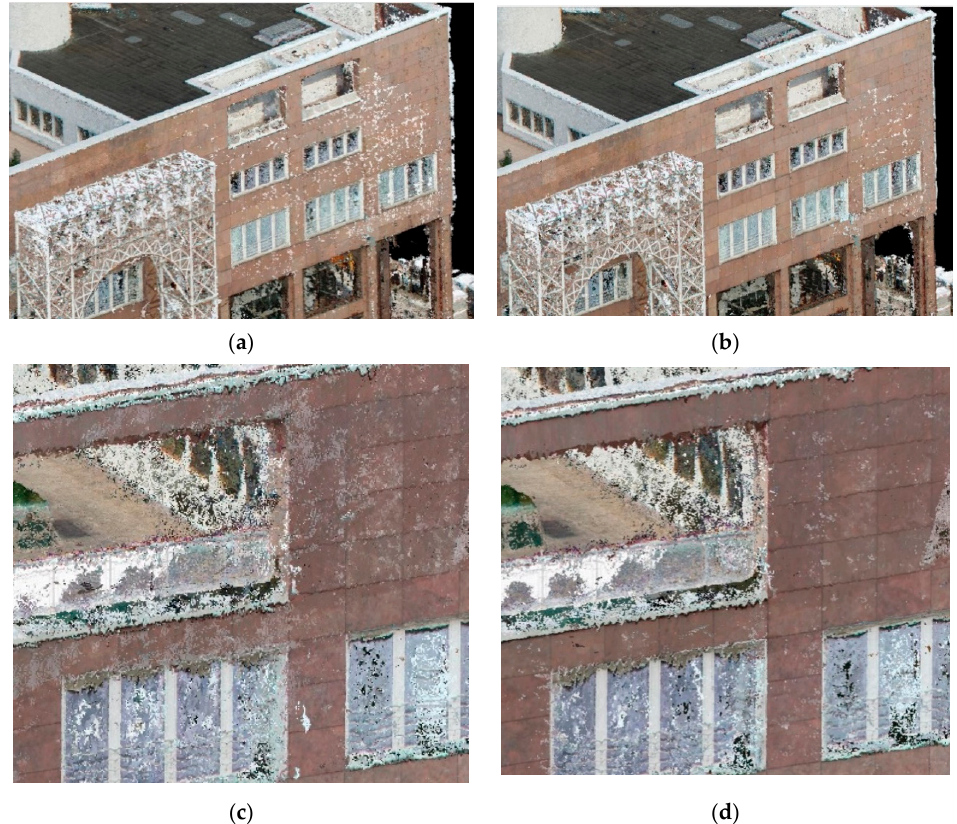
Figure 17. Qualitative evaluation and comparisons of the dense point clouds derived from the standard photogrammetric workflow ( a , c ) and after the proposed filtering method ( b , d ).